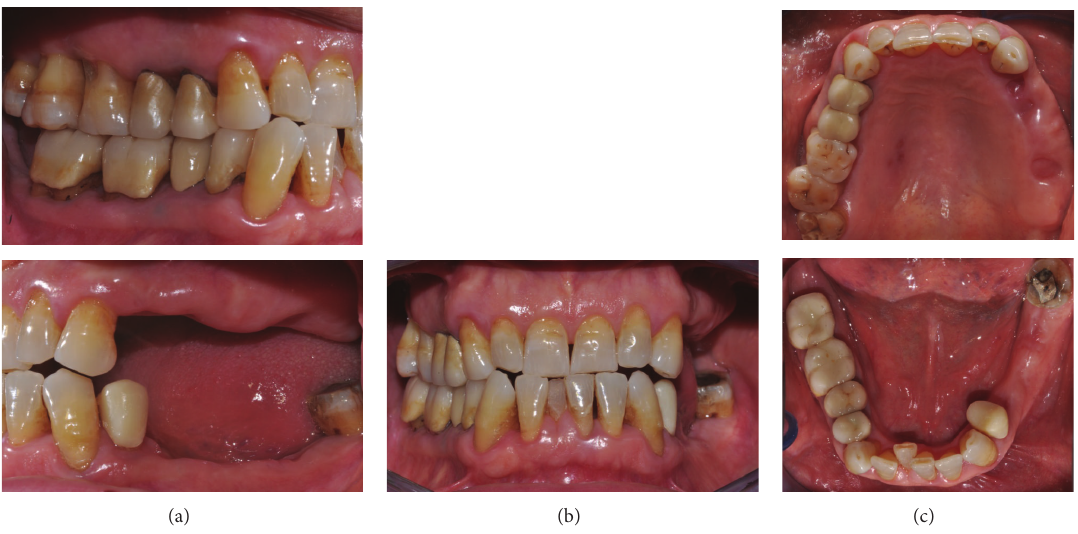
Figure 2: Clinical condition after periodontal treatment: (a) lateral view, (b) frontal view, and (c) occlusal